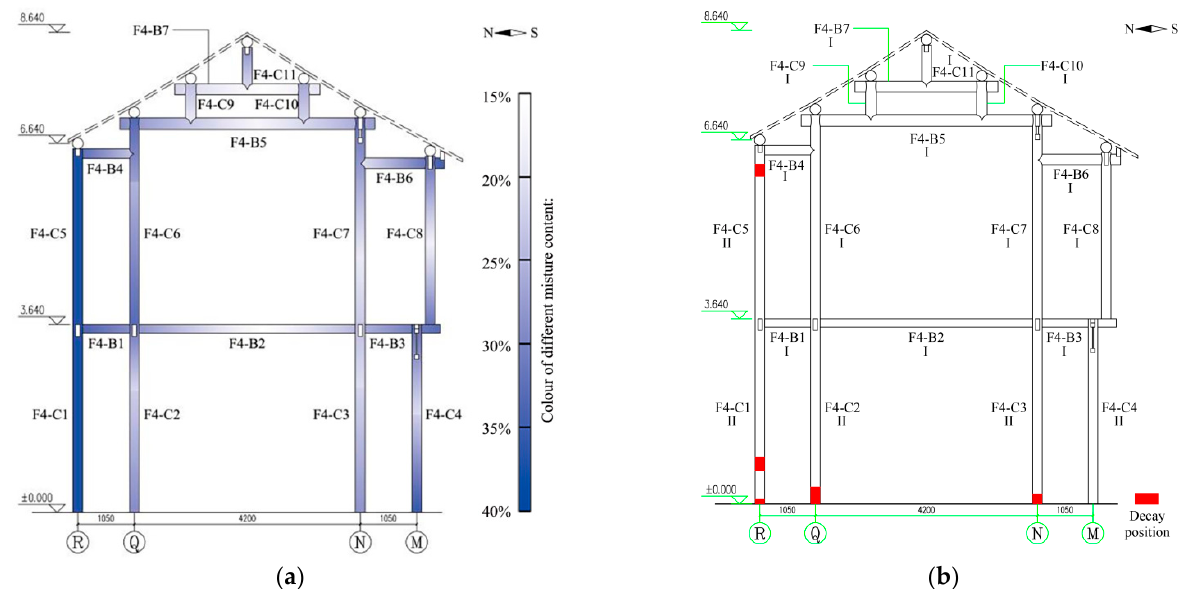
Figure 15. Moisture content and decay of F4 in Fujiu Zhou house; ( a ) schematic diagram of moisture content; ( b ) schematic diagram of decay position and decay grade.